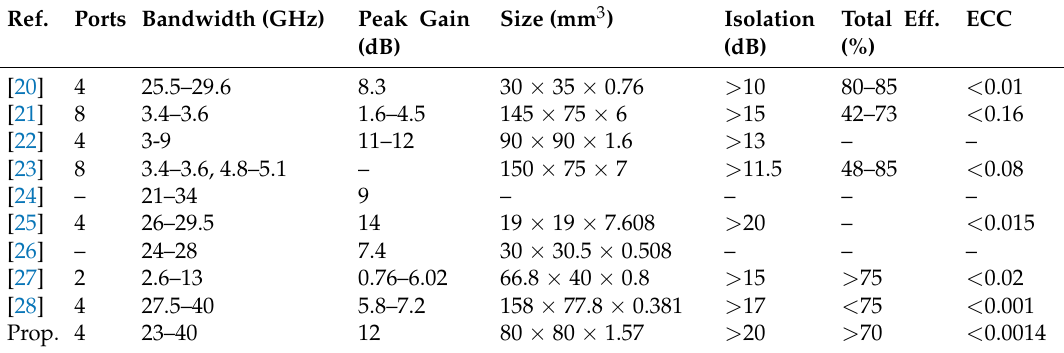
Table 3. Performance comparison with previous published literatures.